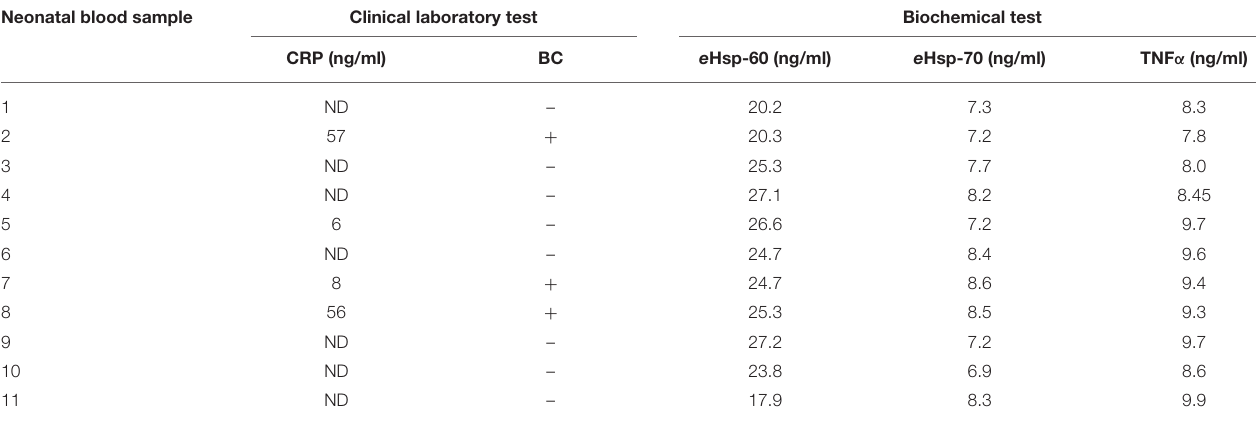
TABLE 3 | Comparison between clinical laboratory and biochemical test in early-onset neonatal sepsis. Neonatal blood sample